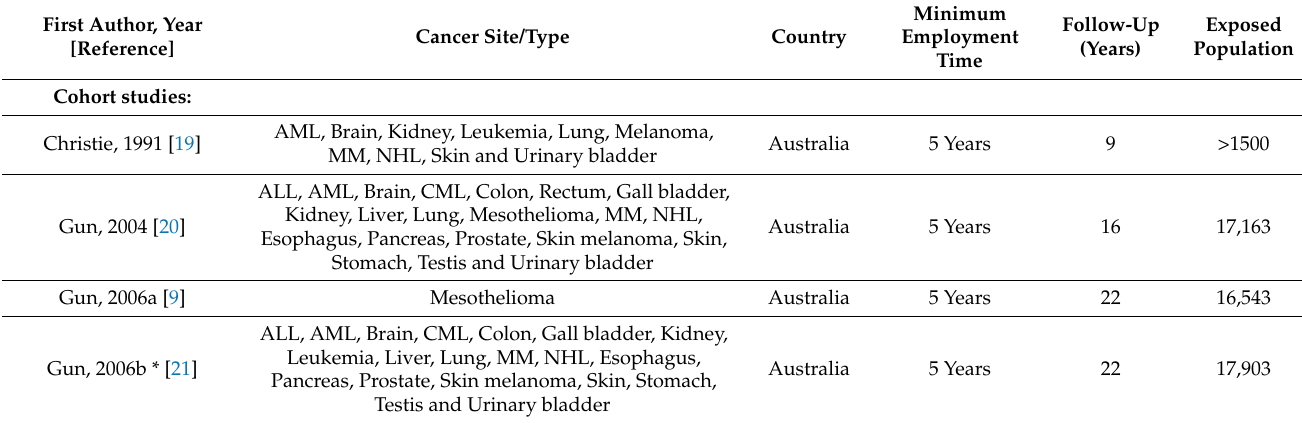
Table 1. Characteristics of the studies on petroleum